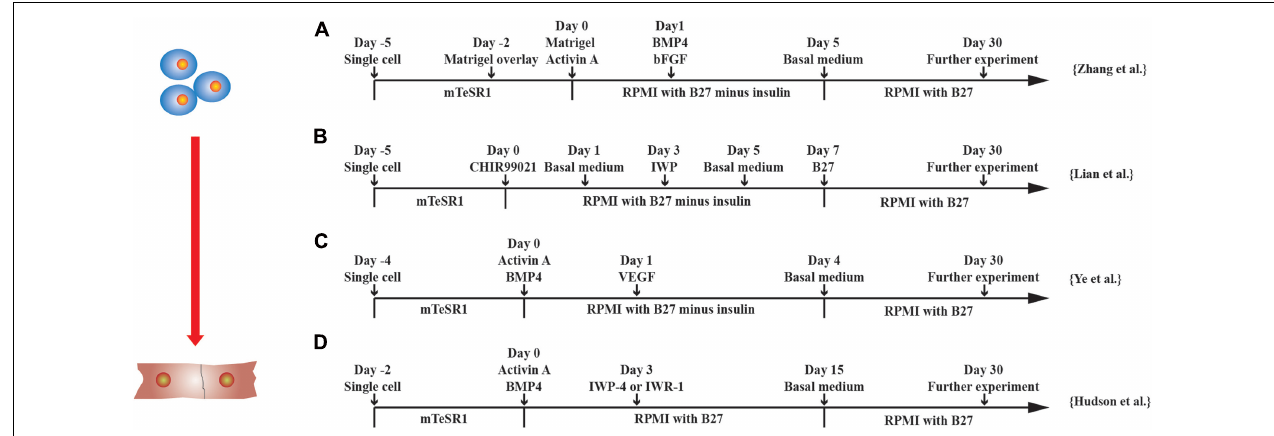
FIGURE 2 | Schematic diagram of differentiation of hPSCs into cardiomyocytes. (A) Schematic diagram of matrix sandwich protocol. Extracellular matrix application promoted epithelial–mesenchymal transition of human PSCs. (B) Schematic diagram of GiWi small molecule differentiation protocol, which proved that timing regulation of Wnt signal was critical. (C) Schematic diagram of activin-A/BMP-4/VEGF protocol, which efficiently differentiated cardiomyocytes from both integrated and non-integrated hiPSCs. (D) Schematic diagram of flexible Wnt signal suppression protocol, which indicated that the differentiation of various cell types can be flexibly